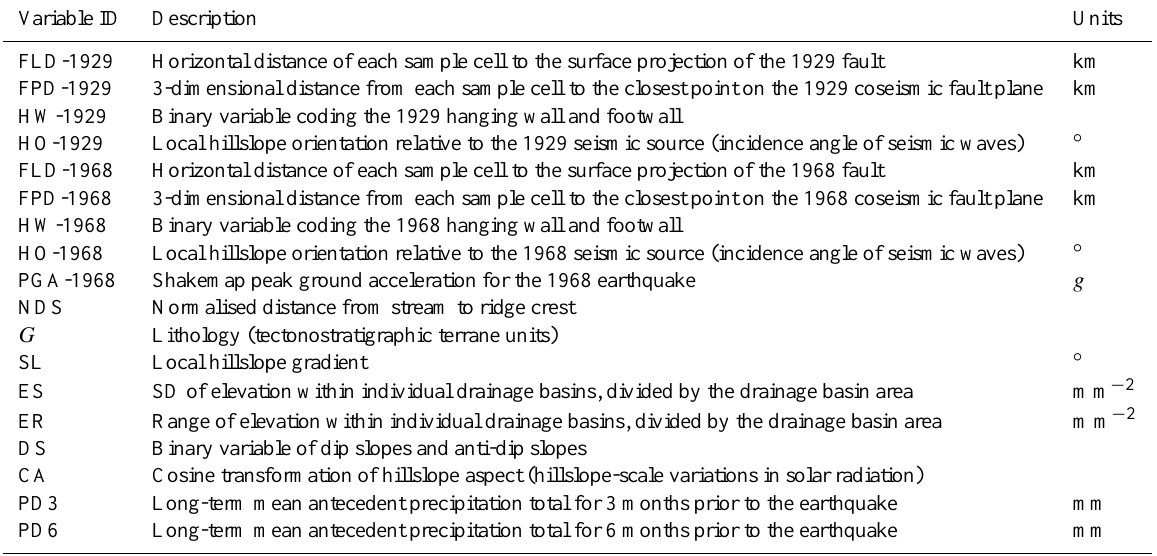
Table 3. Potential predictor variables, ID codes, descriptions and units. Variable